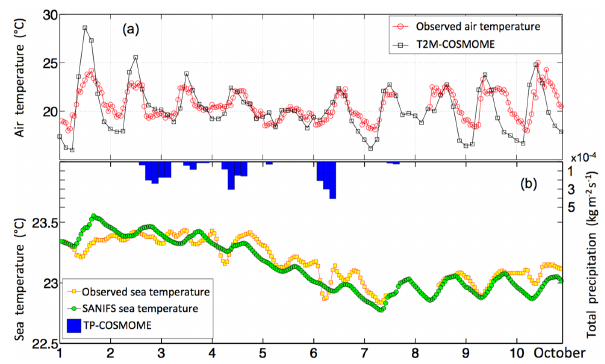
Figure 11. Bottom panel: hourly time series of sea temperatures at a 5m depth from the surface (green circles) compared with the measured series (yellow squares) for P1 station; blue histograms represent the COSMOME analysis of TP. Top panel: time series of observed air temperature at P1 station (red circles) and 2m air temperature of COSMOME (black squares).